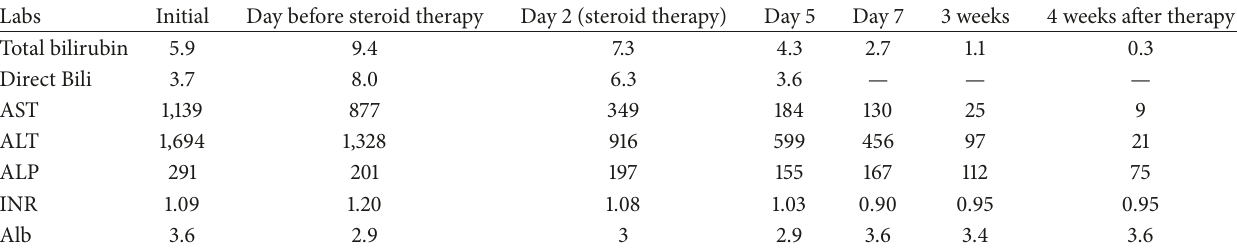
Table 1: Liver function studies before and after initiation of treatment with oral prednisone